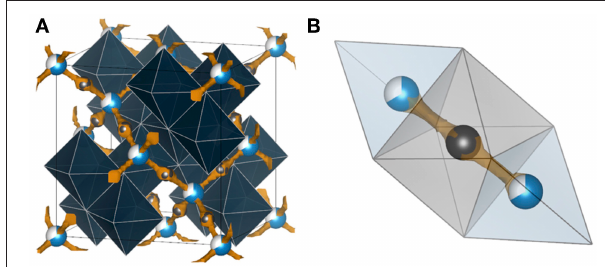
FIGURE 11 | Bond valence energy landscape (orange) for Al (light blue) at 0.52eV in AlVO 3 (ICSD #49645). (A) Dark blue polyhedra denote the 16 d site, which is occupied by V (2/3) and Al (1/3) and coordinated by eight oxygen atoms. Half of all Al in the structure occupies the 8 a site and is suggested to be part of a 3D pathway. This network coincides with the hopping positions calculated by VDP (gray). (B) For aluminum migration, an octahedral site